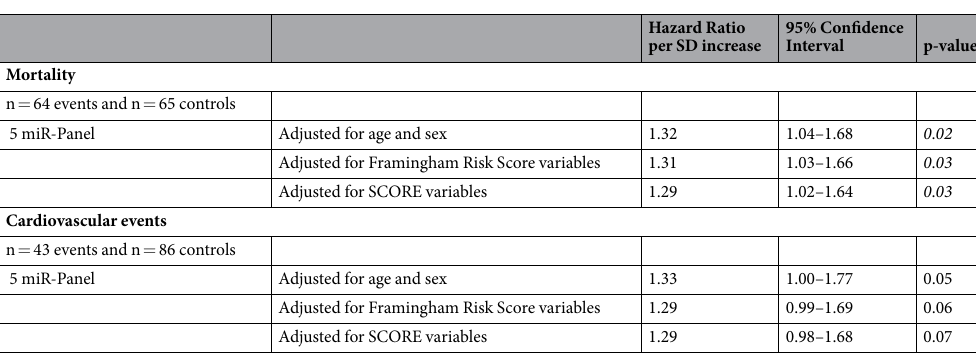
Table 4. Prognostic value of the 5 miR Panel in the validation study cohort (SHIP).